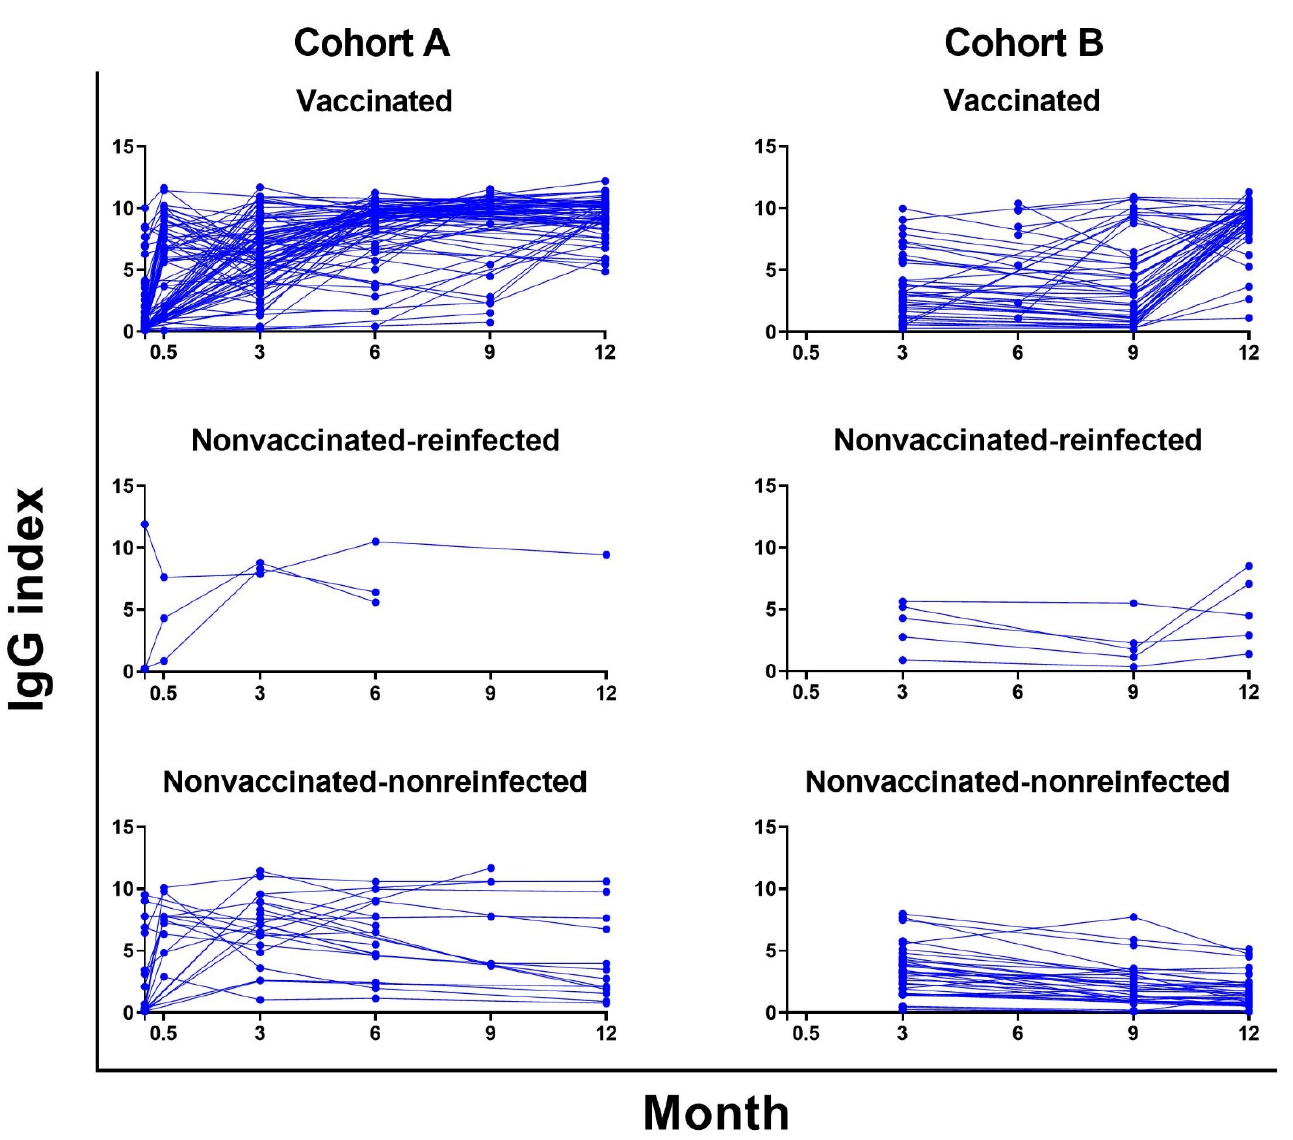
Figure 3. The dynamics of IgG antibodies in individual patients and the effect of the vaccination and reinfection in patient cohorts A (left column) and B (right column). The charts depict significant increases in antibody levels in groups of vaccinated and non-vaccinated reinfected patients at month 12.